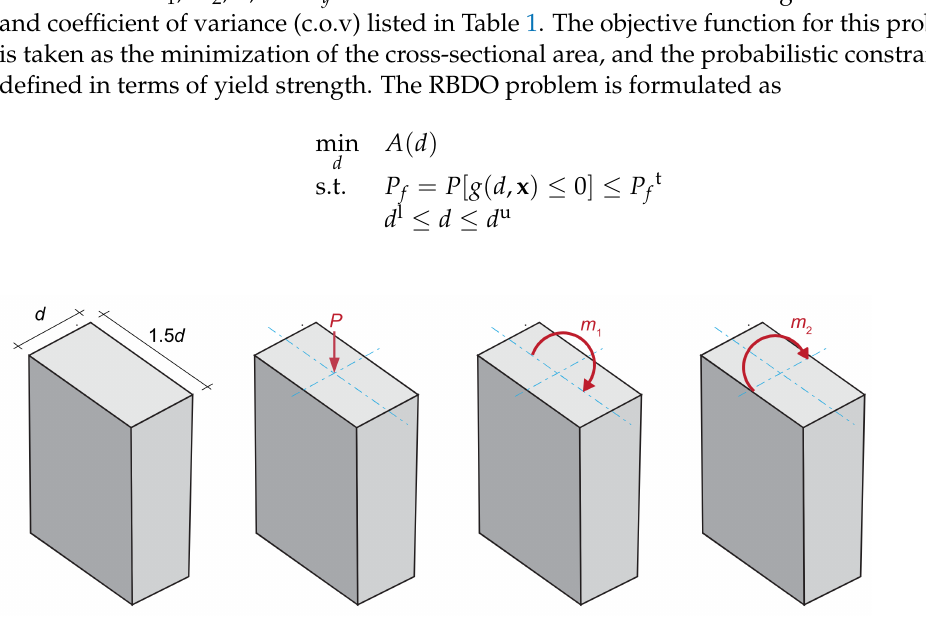
Figure 3. Short column dimension and loading profiles. Table 1. Description of random variables for the short column optimization